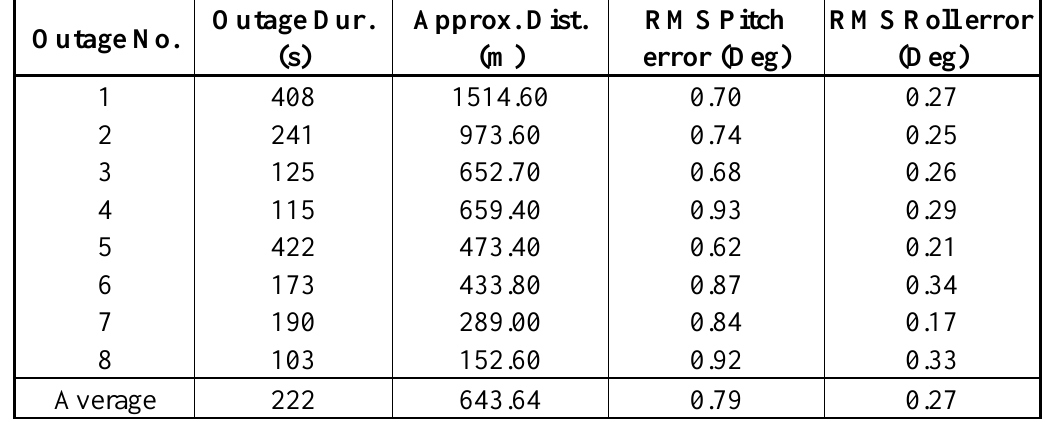
Table 5. RMS error in pitch and roll for the natural outages whose duration exceeds 100 s. Outage